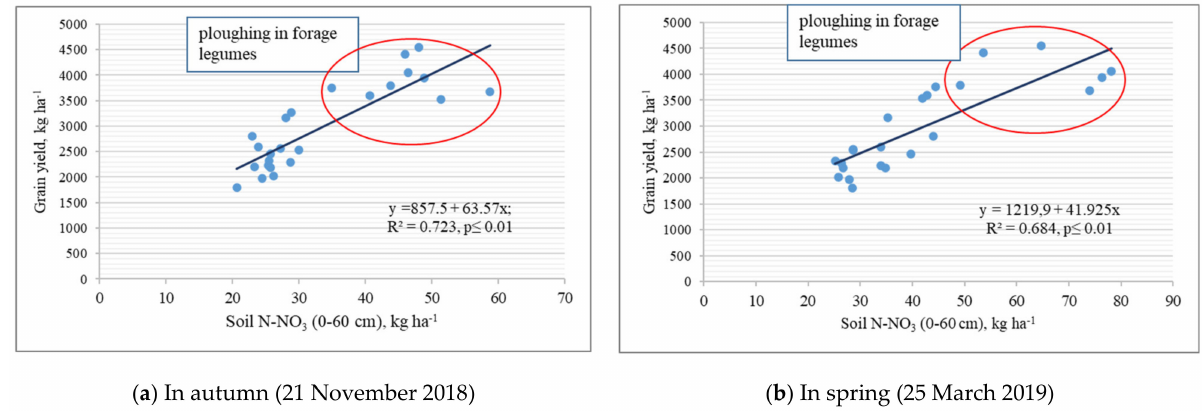
Figure 3. Dependence of winter wheat grain yield on N-NO 3 content accumulated in soil (0–60 cm) during autumn ( a ) and spring ( b